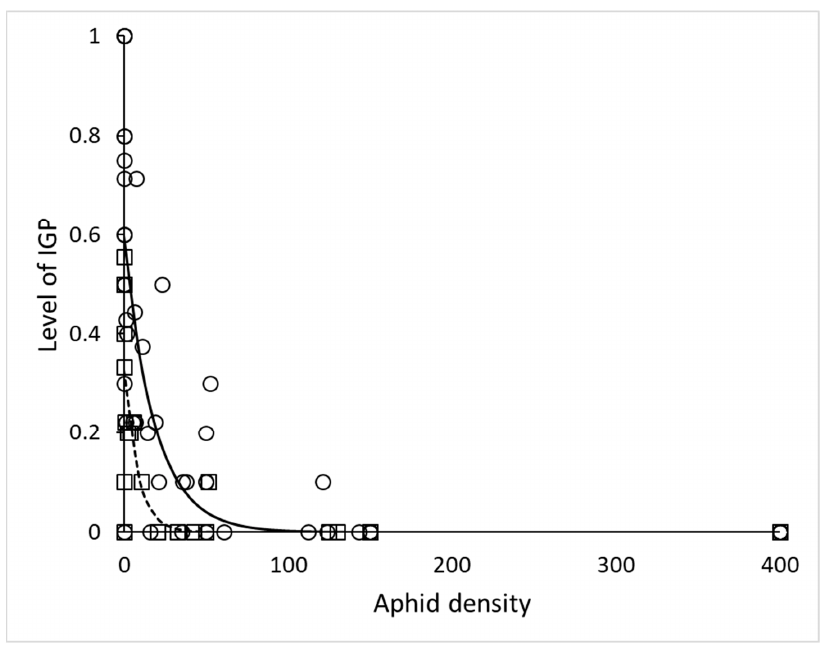
Figure 1. Decrease of the intraguild predation level with increasing density of extraguild prey (EGP) in the simple arena. Circles and solid line: treatments containing larvae of Hippodamia variegata and Chrysopa carnea , y = 0.60*exp( − 0.054*x), N = 48; squares and dashed line: treatments containing adults of H. variegata and larvae of C. carnea , y = 0.33*exp( − 0.119*x), N =